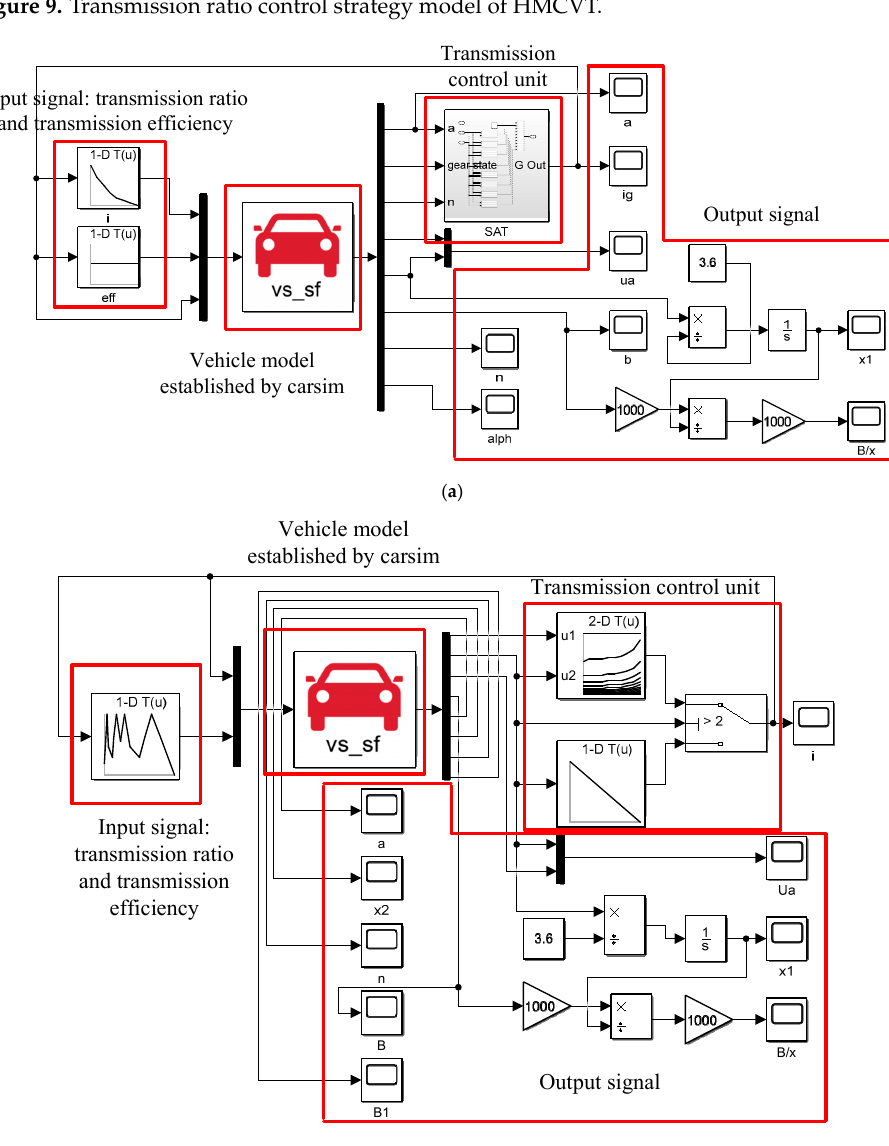
Figure 10. Simulation model of pickup. ( a ) pickup with SAT; ( b ) pickup with